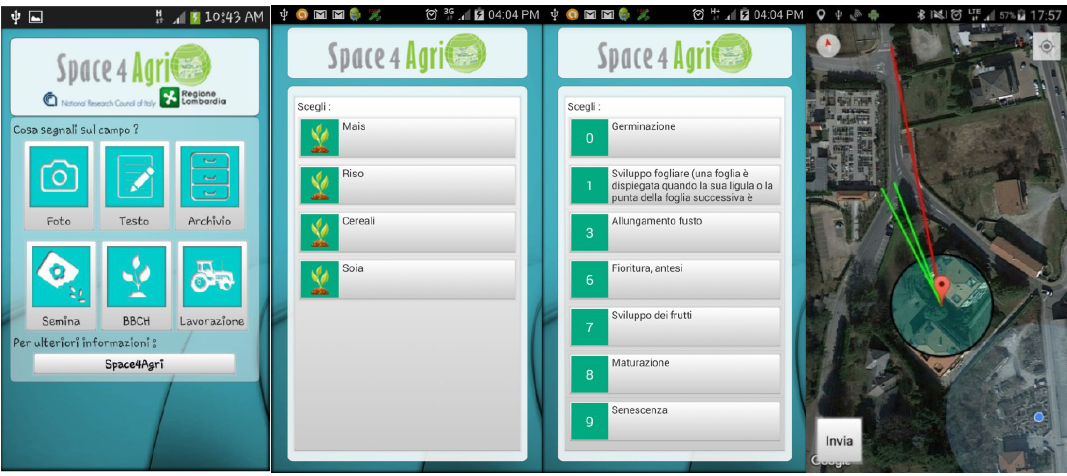
Figure 3. S4A smart app screenshots showing the main menu for VGI creation, the first and second level entries of the compact BBCH agronomic ontology and the representation of the GPS imprecision and camera orientation (depicted by the green line angle).